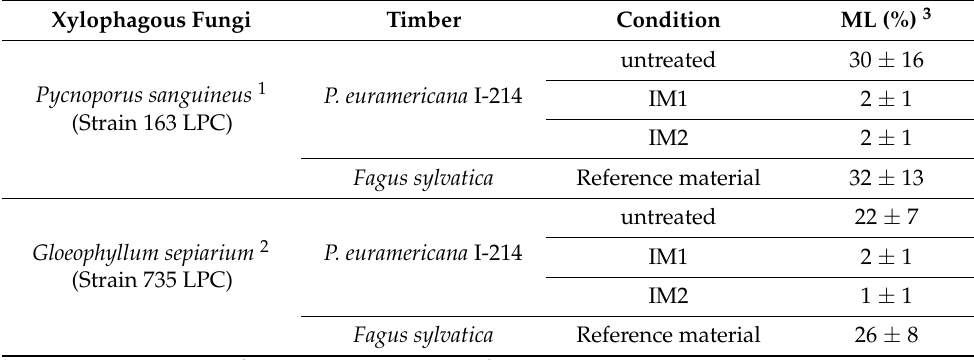
Table 4. Effect of treatments on mass loss for Populus canadensis I-214 wood-blocks exposed to Gloeophyllum sepiarium and Pycnoporus sanguineus. Notice that two different doses of tebuconazole were applied to the different woods: IM1 (0.375 mg/mL) and IM2 (0.750